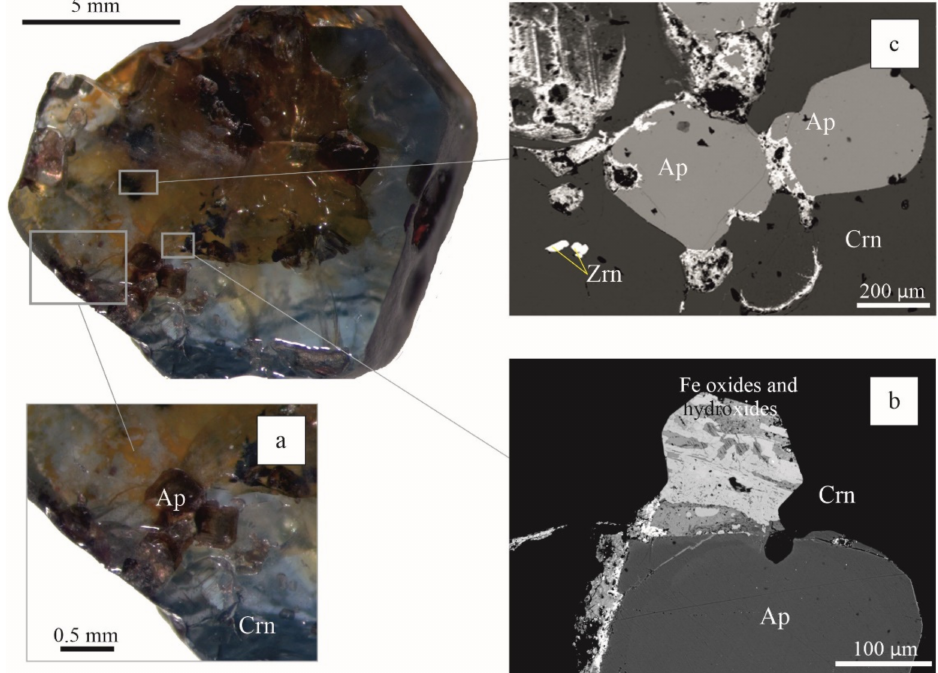
Figure 8. Mineral and melt inclusions in the Naryn-Gol Creek sapphires. ( a )—apatite inclusions; ( b )—apatite and primary melt inclusions; ( c )—apatite, zircon and primary melt